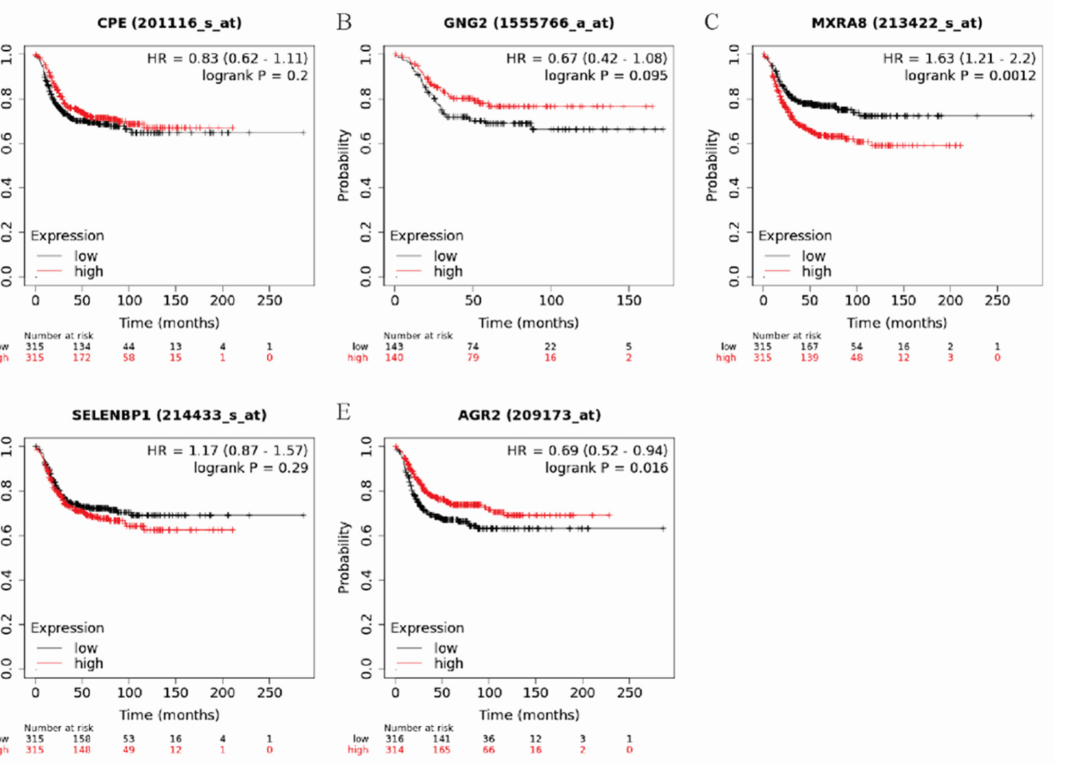
Figure 4. Distant metastasis free survival (DMFS) curves from Kaplan-Meier plotter using basal-like breast cancers and median cut-offs for ( A ) CPE, ( B ) GNG2, ( C ) MXRA8, ( D ) SELENBP1, and ( E ) AGR2. The red line indicates elevated gene expression while the black line indicates reduced gene expression. The hazard ratio (HR) and significance (logrank P) are indicated in the upper right hand corner of each